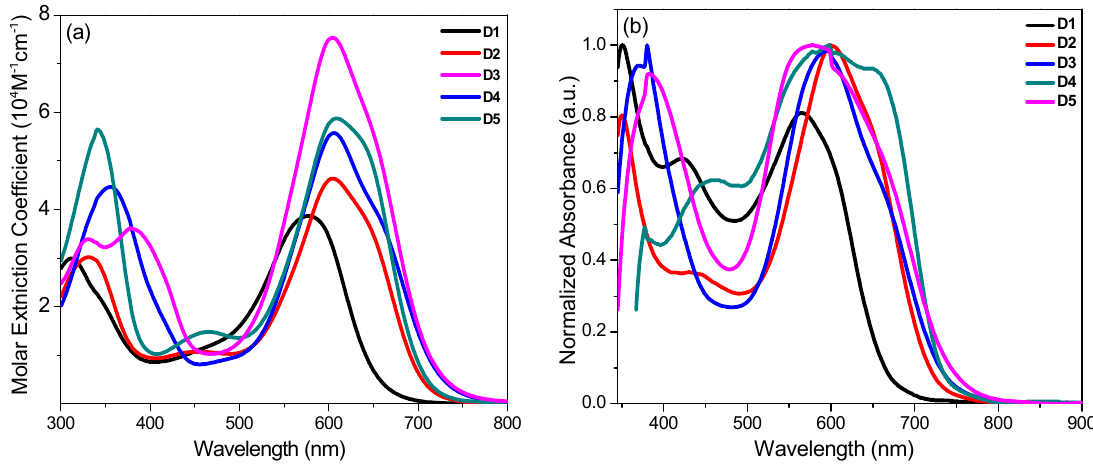
Figure 2. UV–Visible spectra in dichloromethane solution (2 × 10 − 5 M) ( a ), on TiO 2 ( b ). Table 1. Photophysical and electrochemical properties of the dyes D1 – D5